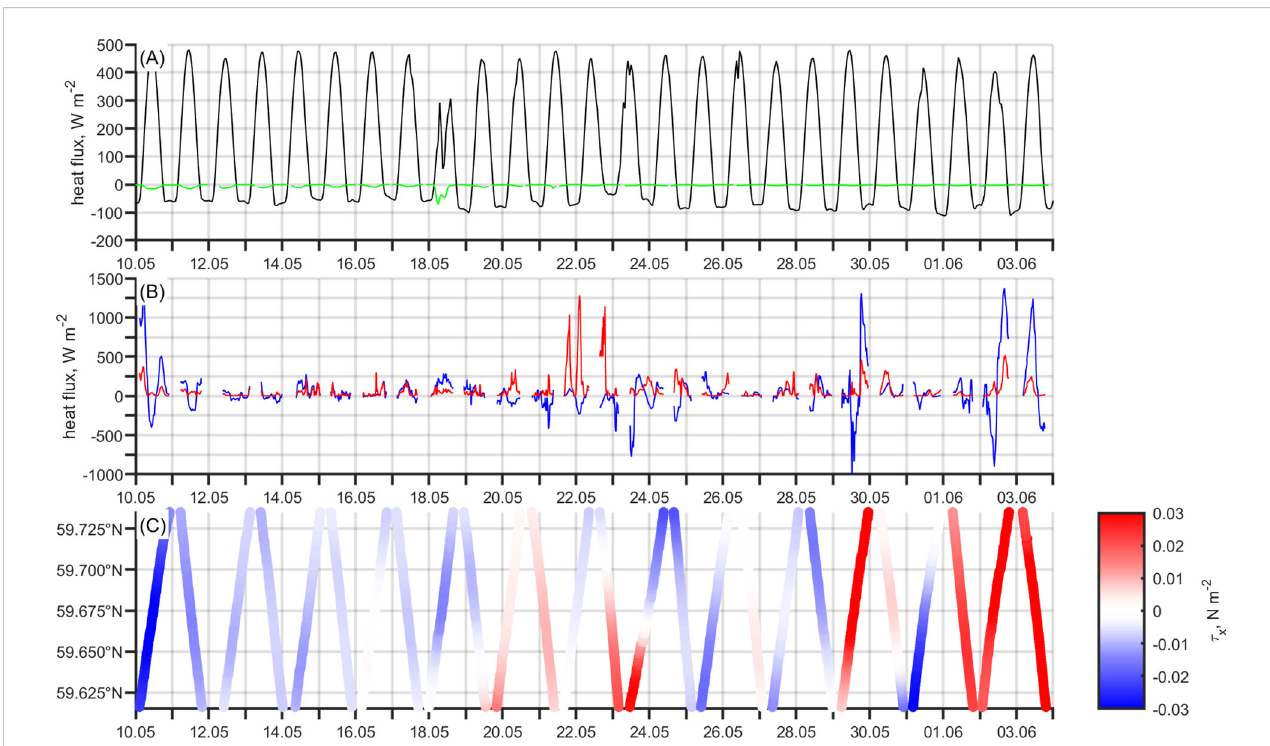
FIGURE 6 Equivalent heat fl uxes associated with restrati fi cation processes during the study period in May – June 2018: (A) surface heat fl ux (black) and freshwater fl ux (green), (B) submesoscale overturning due to wind-driven processes (blue) and due to mixed layer baroclinic instability (red). (C) Component of wind stress perpendicular to the glider section as a function of time and